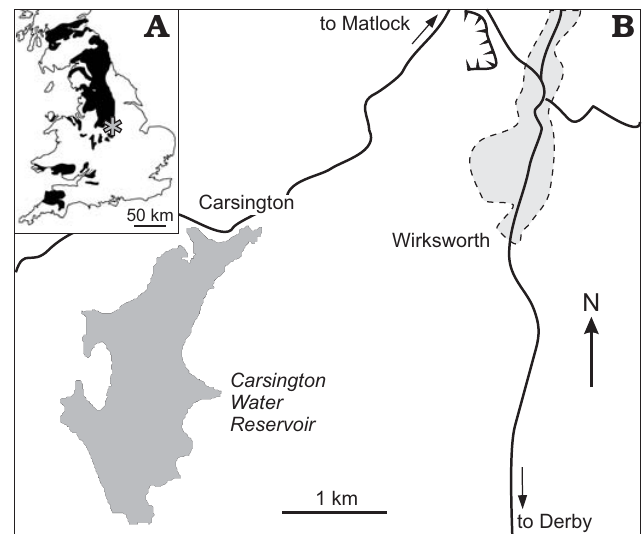
Fig. 1. A . Sketch map of Carboniferous outcrops (black) in Britain with the position of study area in Derbyshire (asterisk); after Dineley and Metcalf (1999). B . The position of the studied outcrop, currently submerged by the Carsington Water Reservoir.